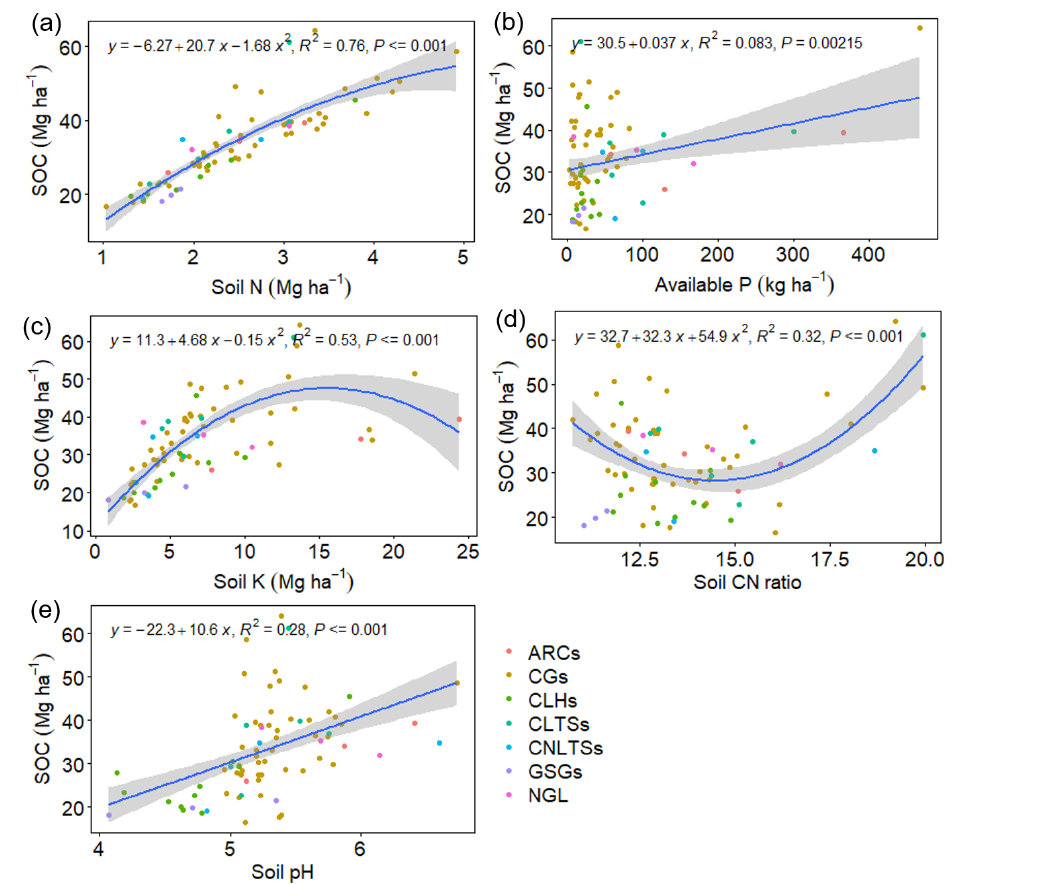
Figure 4. Bivariate regression curves showing the relationship between SOC and the measured soil variables. The grey band shows the 95% confidence interval. CLTSs – cut–use legume trees/shrubs; NGL – native grassland; CGs – cut–use grasses; ARCs – arable crops; CNLTSs – cut–use non-legume trees/shrubs; CLHs – cut–use legume herbs; GSGs – grazed–seeded